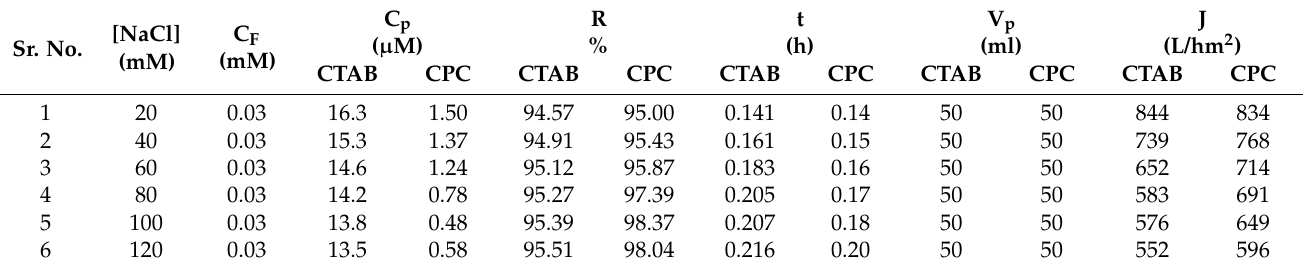
Table 4. Rejection coefficient, R%, and permeate flux, J, of Naphthol Green B for different electrolyte concentrations, NaCl, at fixed dye concentration, C F , dye concentration in permeate solution, C p , filtration time, t, permeate volume, V p